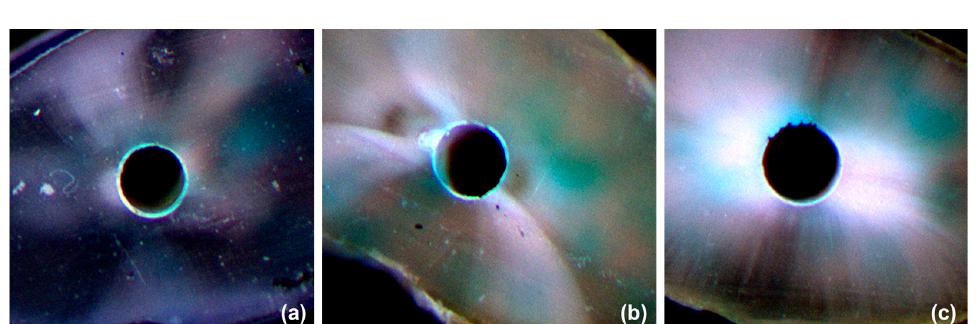
Figure 3. Representative images of the adhesive pattern of Bio-G ( a ), BioRoot RCS ( b ), and iRoot SP ( c ) under Leica microscopy.